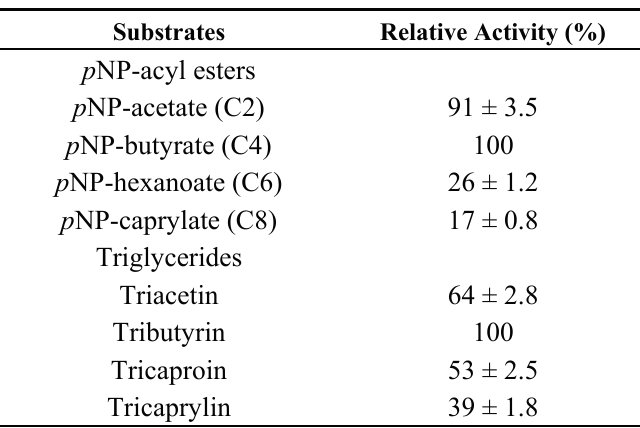
Figure 5. Effects of pH and temperature on the activity and stability of HydS14. ( A ) The optimum pH was determined at 70 °C for 5 min. Filled circles represent citrate phosphate buffer (pH 3.0–7.0), filled squares represent Tris–HCl buffer (pH 7.0–9.0), and filled diamonds represent glycine-NaOH buffer (pH 9.0–10.0); ( B ) The pH stability of the enzyme was determined by measuring the remaining activity after incubating the enzymes at different pH values at 60 °C for 30 min. Filled circles represent 100 mM citrate phosphate buffer, filled squares represent 100 mM Tris–HCl, and filled triangles represent 100 mM glycine-NaOH buffer; ( C ) The optimal temperature was measured in 100 mM Tris–HCl buffer (pH 8.0); ( D ) The thermostability of the enzyme was measured in 100 mM Tris–HCl buffer (pH 8.0). Filled circles represent 50 °C, filled squares represent 60 °C, filled triangles represent 70 °C, and filled diamonds represent 80 °C. Table 2. Substrate specificity of